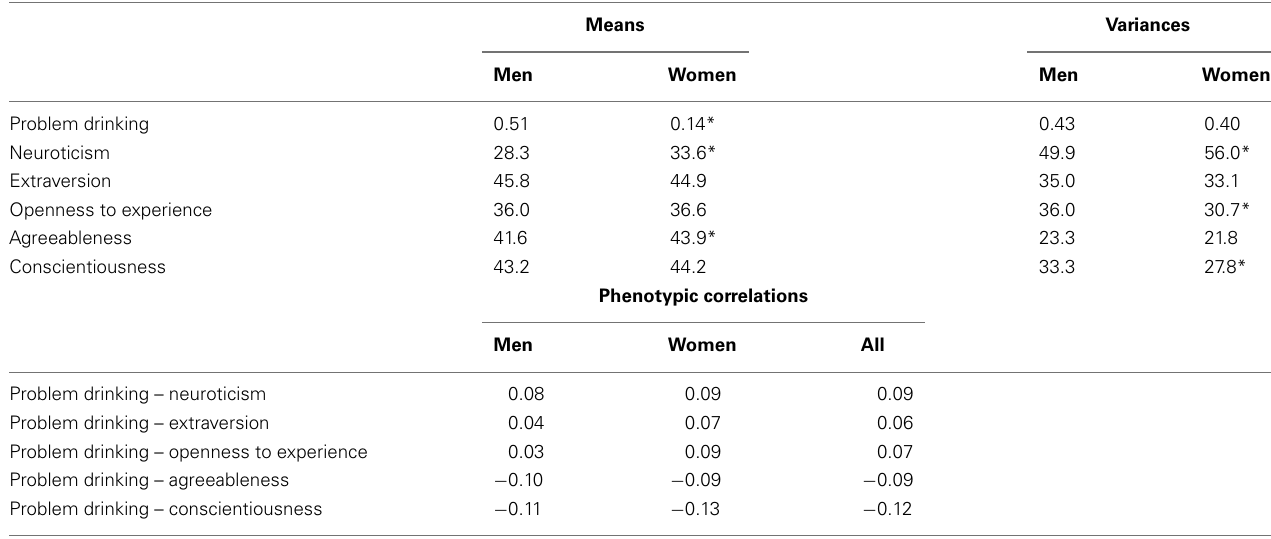
Table 2 | Means, variances, and phenotypic correlations for problem drinking and the FFM personality scales as obtained from the saturated